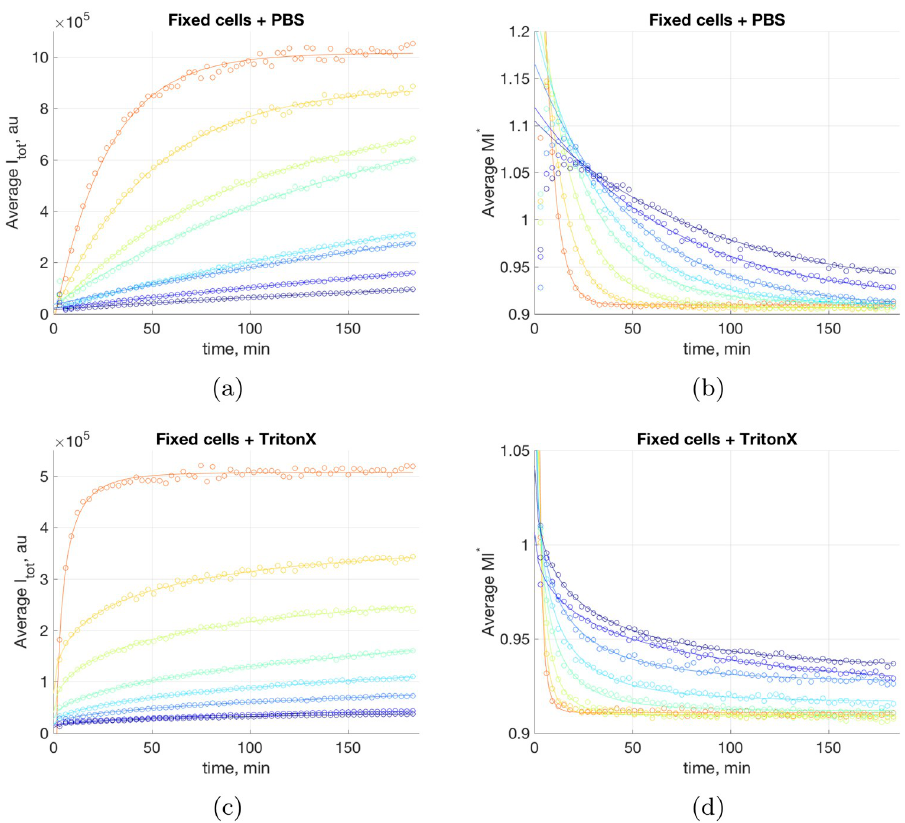
Fig 5. (a) I and (b) moment of inertia M 2 , for different dye concentrations, population average, fixed cells. (c) I tot and (d) moment of inertia M 2 , for different dye concentrations, Triton X-100-treated fixed cells, conditions as in (a) and